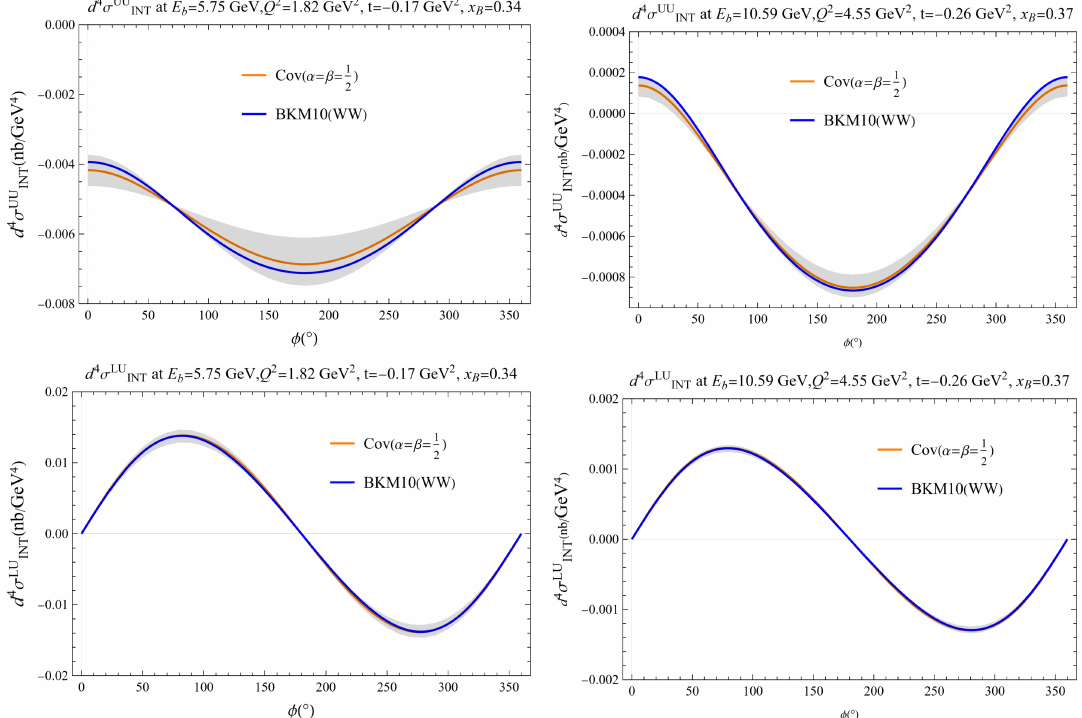
Figure 13 . Comparison of the unpolarized four-fold pure DVCS cross-section d 4 σ UU DVCS cross-sections almost have no light cone dependence, while they differ a bit from the BKM10 results with WW relations.